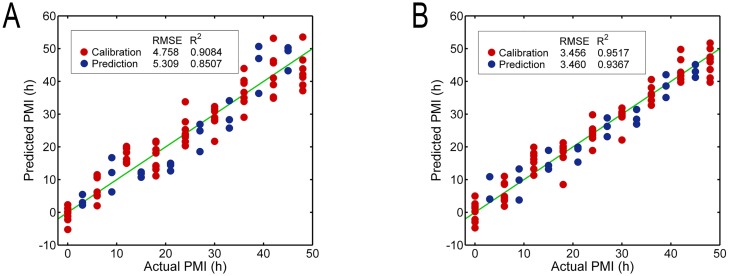
Predicted versus actual PMI from the calibration and prediction sets.(A) Prediction results using the full-spectrum PLS model and (B) using the GA-PLS model. The green lines are the reference line corresponding to the perfect prediction.